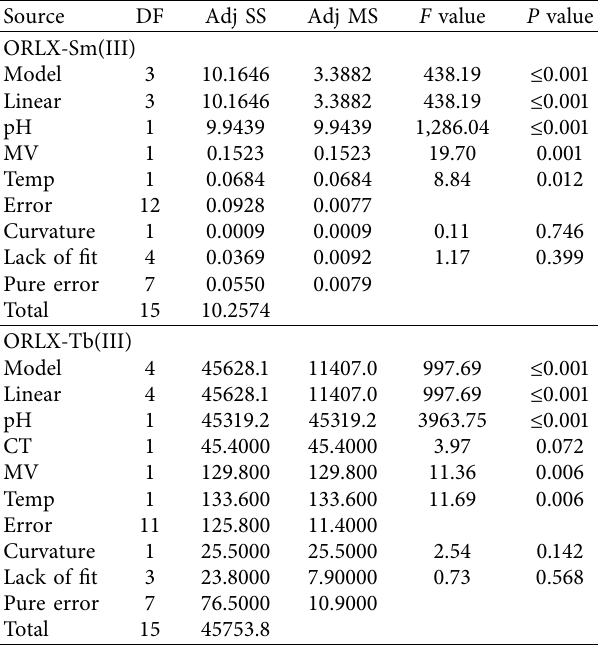
Table 3: Analysis of variance (ANOVA) for FI of ORLX-Sm(III) and ORLX-Tb(III)